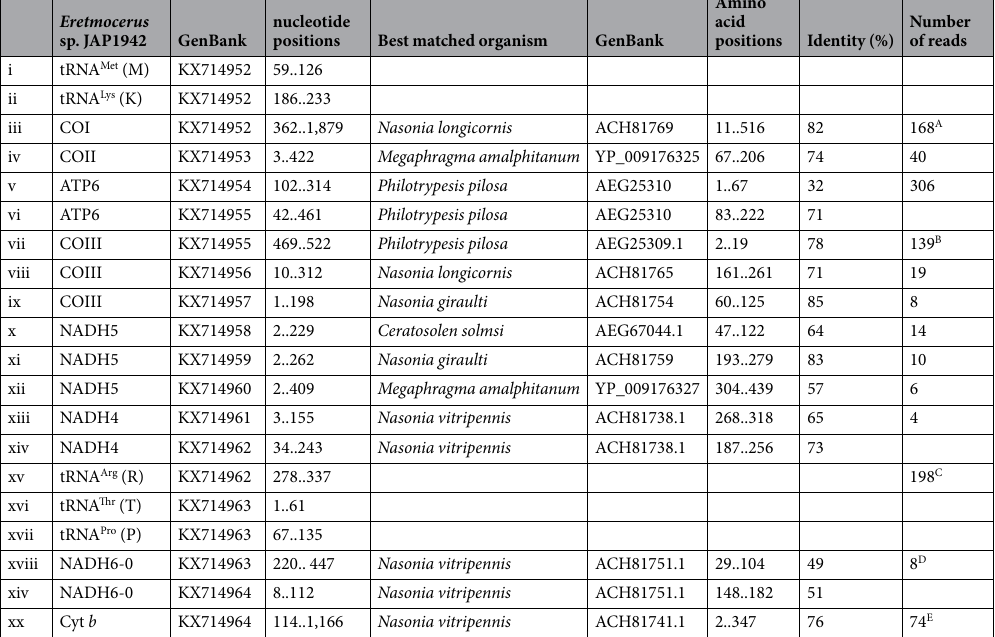
200 bp long and extended across to the mtDNA COI gene (Supplementary Fig. 1). Though unusual, two-arms clover leaf tRNA secondary structures are known in diverse organisms from mammals (e.g., bovine 18 ) to arthro-